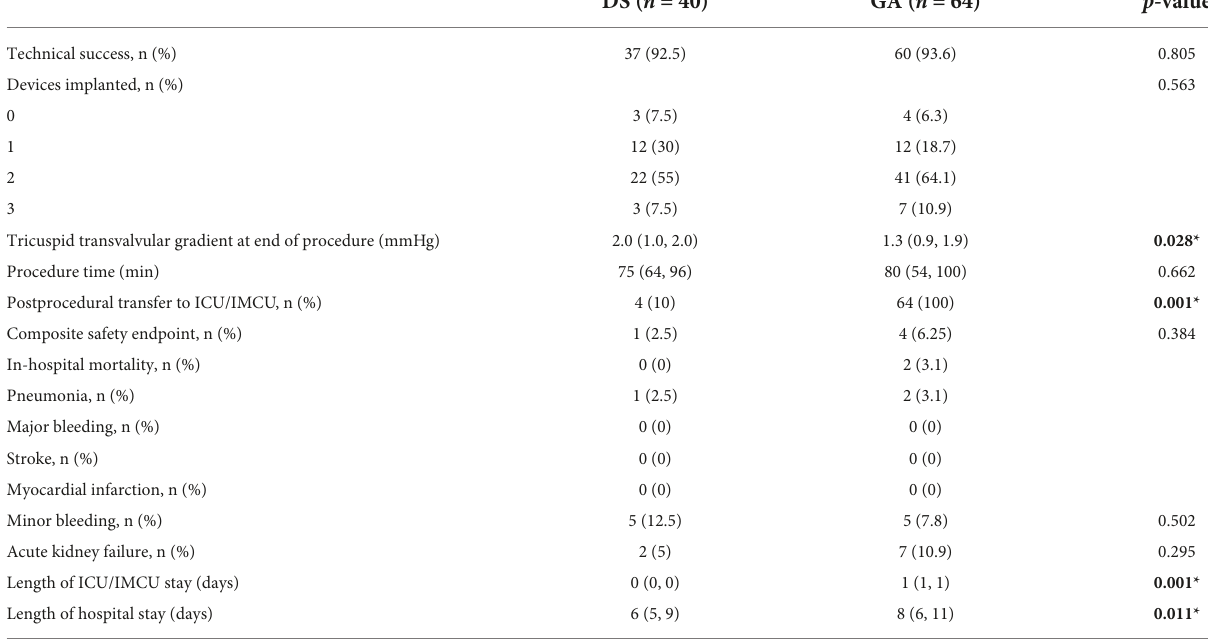
TABLE 3 Procedural outcome categorical variables are reported as absolute values and percentages, whereas continuous data are expressed as median with interquartile